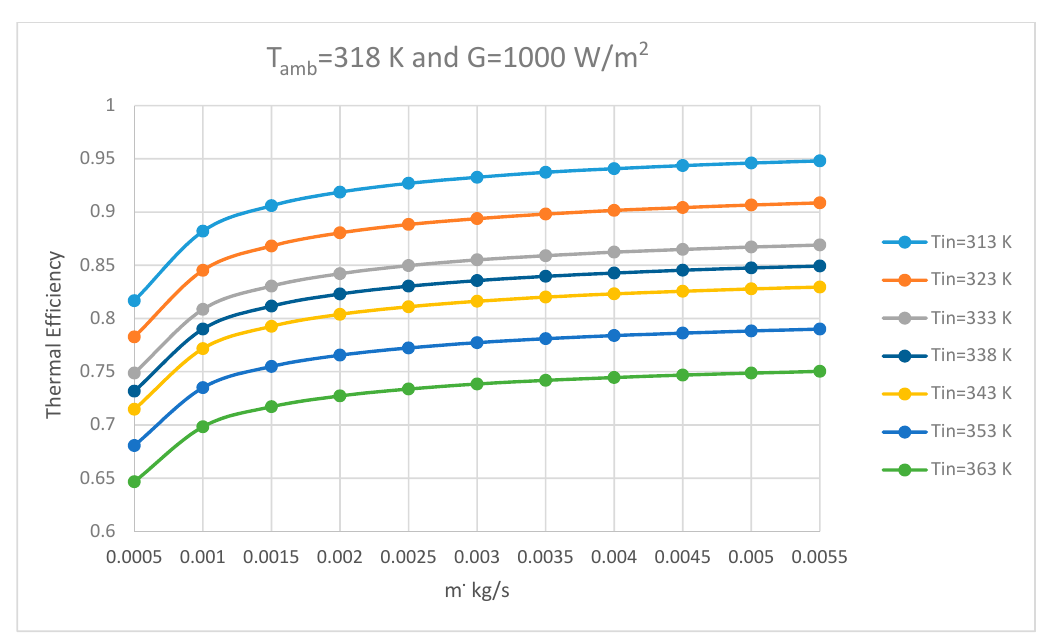
Figure 16. Thermal efficiency ( η th ) for different inlet temperature versus